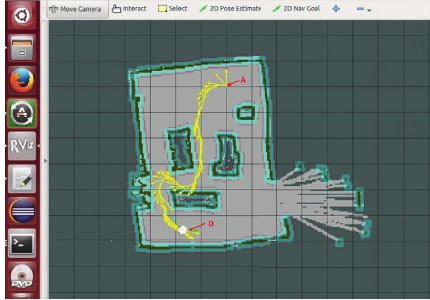
Figure 5: Response of the service robot for voice request.